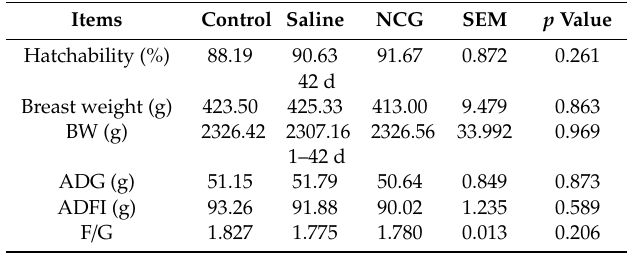
Table 2. Hatchability, growth performance, and breast muscle weight of